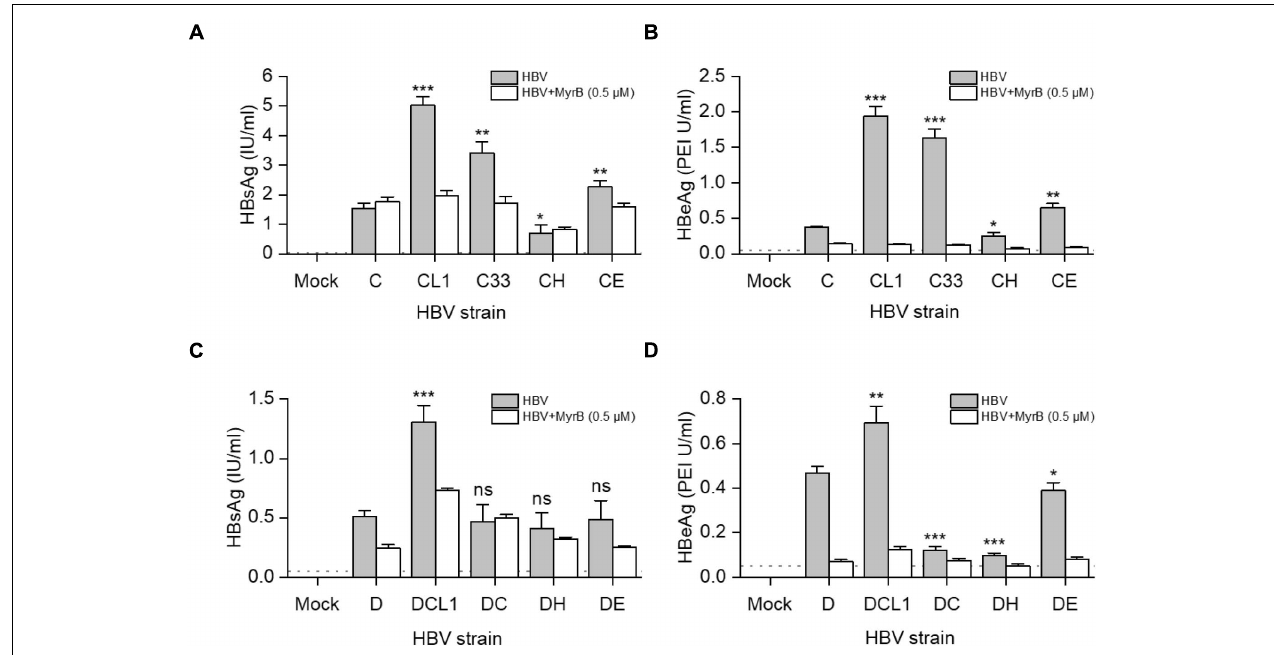
FIGURE 6 | Impact of preS1 N-terminal sequences on HBV infectivity in HepG2-NTCP cells. HepG2 cells were transfected with plasmids containing 1.05-mer HBV genome from C-derived (A,B) or D-derived (C,D) strains under the control of CMV promoter. Three days post transfection, culture supernatants were collected and concentrated for HBV virion preparation. The multiplicity of infection of 5000 genome equivalents per cell were inoculated into HepG2-NTCP cells. MyrB was used for blocking HBV entry. Extracellular HBsAg (A,C) and HBeAg (B,D) were determined by CLIA at day 7 post infection. The dashed lines indicate the lower limit of quantification of HBsAg (0.05 IU/ml) or HBeAg (0.1 PEI U/ml). The histograms show mean values from one representative experiment. The bars indicate Standard Deviation. The p values were determined using Student’s t test; ns represents no significant, * p < 0.05, ** p < 0.01, *** p < 0.001. HBV, hepatitis B virus; MyrB, Myrcludex